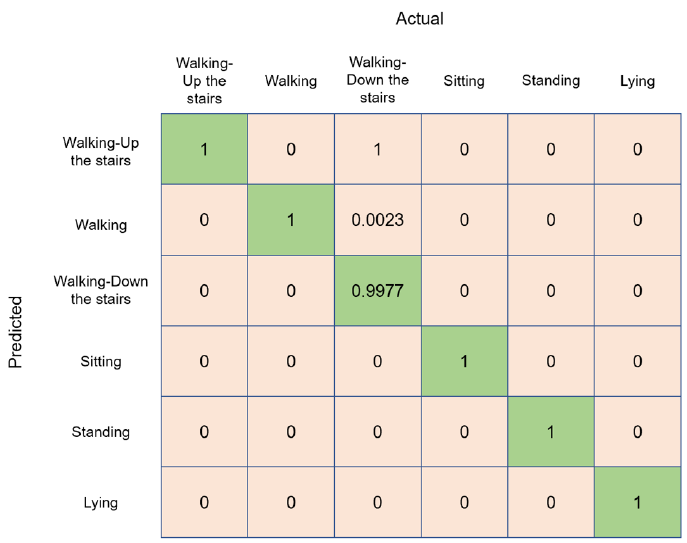
Figure 9. Normalized confusion matrix of the SVSL method.